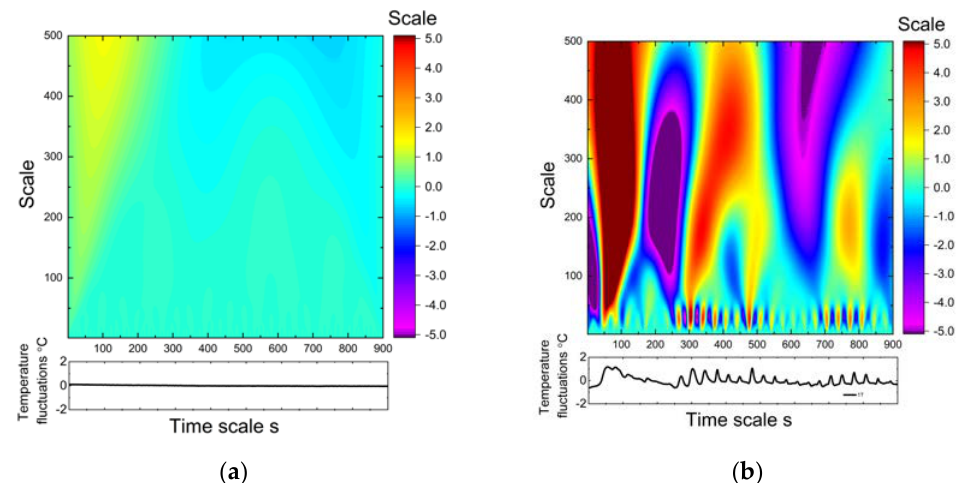
Figure 11. Wavelet analysis of the for the case with ΔT = 11 °C and magnetic induction of ( a ) 0T and ( b ) 1T. For the smaller temperature difference, the cases with the magnetic induction of 1T and 2T were selected. For the case with b 0MAX = 1T, the colormap presents mostly azure color (values near 0) and only two areas for the large scales—yellow-orange in the upper left corner and dark blue in the middle-right upper part can be observed. Those two re- gions suggest small and slow deviation from the mean temperature indicating that the flow is steady and laminar. After introducing the magnetic field of 1T to the system, the character on the colormap changes greatly—small red/blue structures appear at the bot- tom contributes primarily to the background turbulence at the small scales (under 50 s).